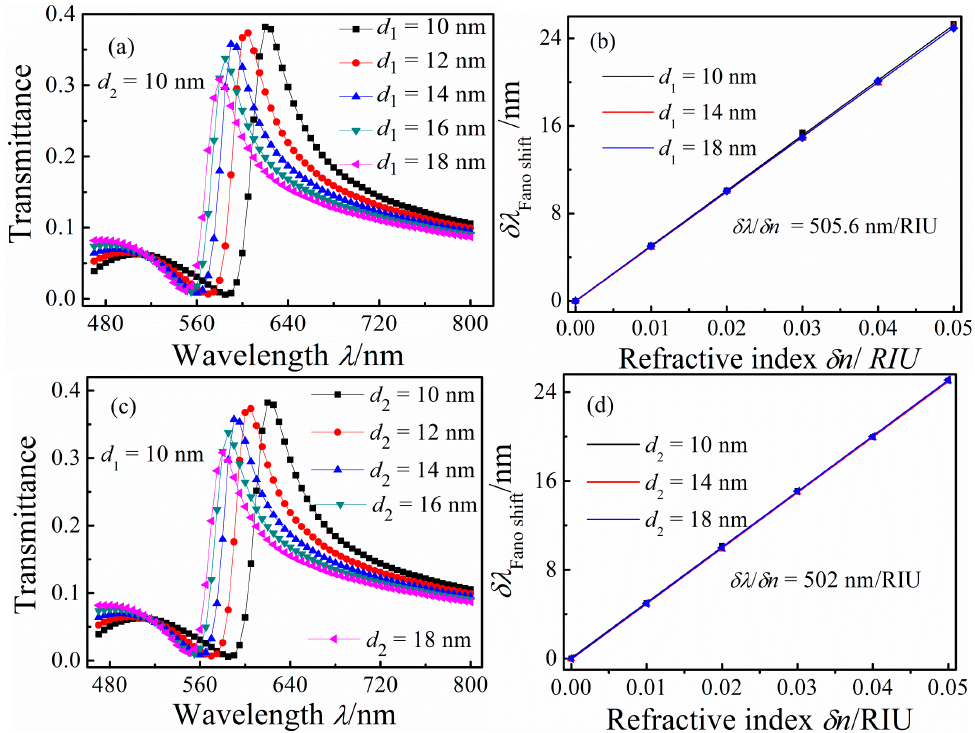
Figure 6. ( a , c ) Transmission spectra for different rectangular cavities width d 1 ( a ) and d 2 ( c ); respectively; ( b , d ) the shift of the Fano resonance peak as a function of δ n with different rectangular cavities width d 1 ( b ) and d 2 ( d ), respectively.